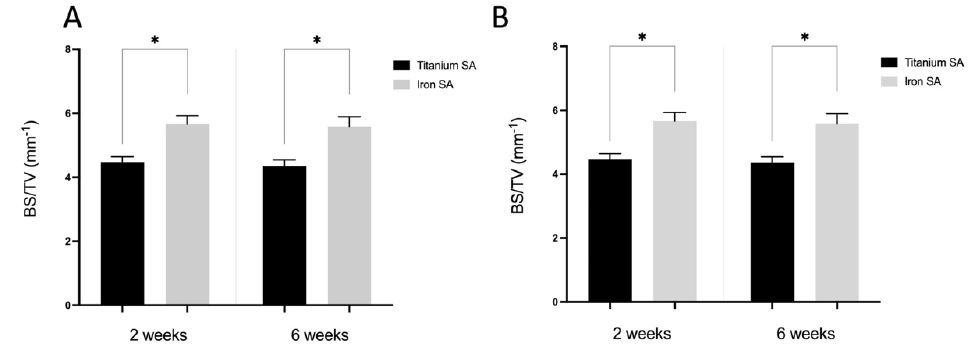
Figure 10. Micro-computed tomography (micro-CT) analysis. Quantitative evaluation of the bone volume (BV) between the bone and SAs. The tissue volume (TV, mm 3 ), BV (mm 3 ), and BS (mm 2 ) were examined in a region of interest (ROI) of 200–1000 μm around the implant. ( A ) BV fraction (BV/TV, %) and ( B ) BS density (BS/TV, mm −1 ) represent the BV rate and bone tissue surface rate, respectively. Mean ± SEM. * p < 0.05.